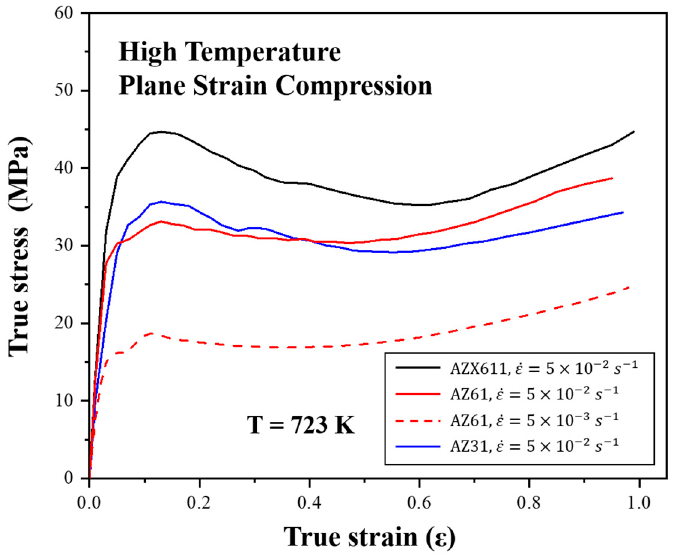
Figure 4. True stress-strain curves for the deformation at 723 K up to the strain of − 1.0 with each strain rate.